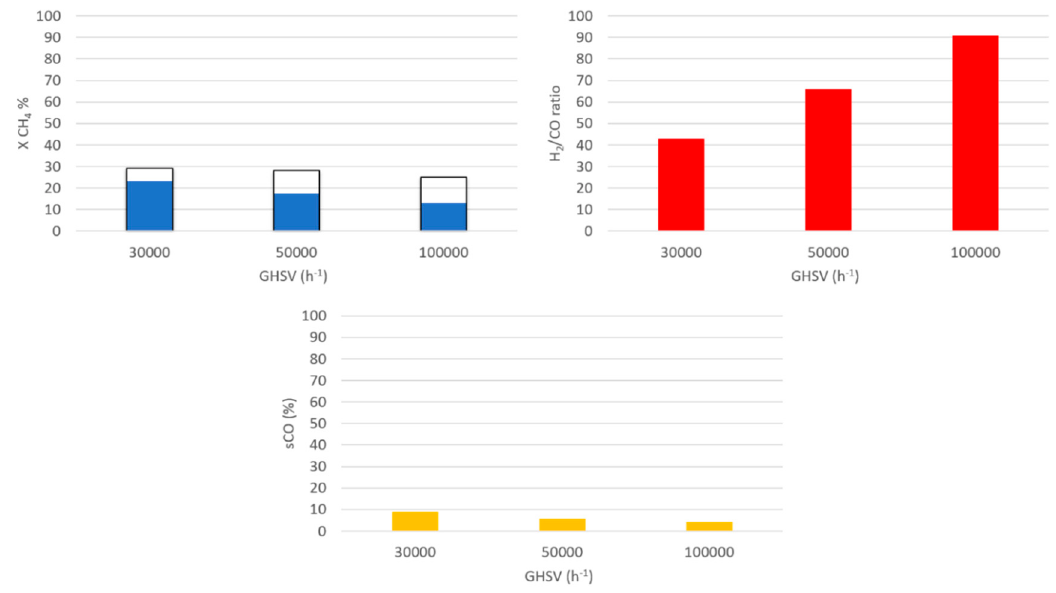
Figure 7. Comparison among tests carried out on Rh0.6-CL-R-CZOm at 1 atm, S/C 2 and 500 °C. The graphs report the methane conversion (blue) with respect to the equilibrium values (white bars with black frames), H 2 /CO ratio (red) and CO selectivity (yellow) versus different Gas Hourly Space Velocity (GHSV).